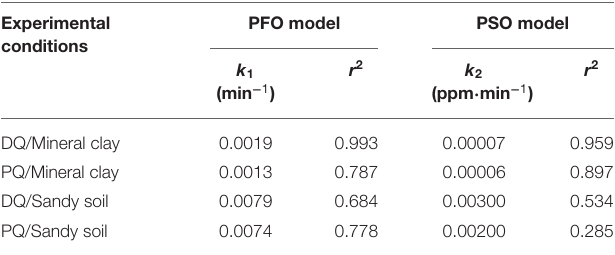
TABLE 3 | Calculated PFO and PSO adsorption kinetics for PQ and DQ dissolved in KCl electrolyte on Mineral Clay and Sandy Soil. Experimental